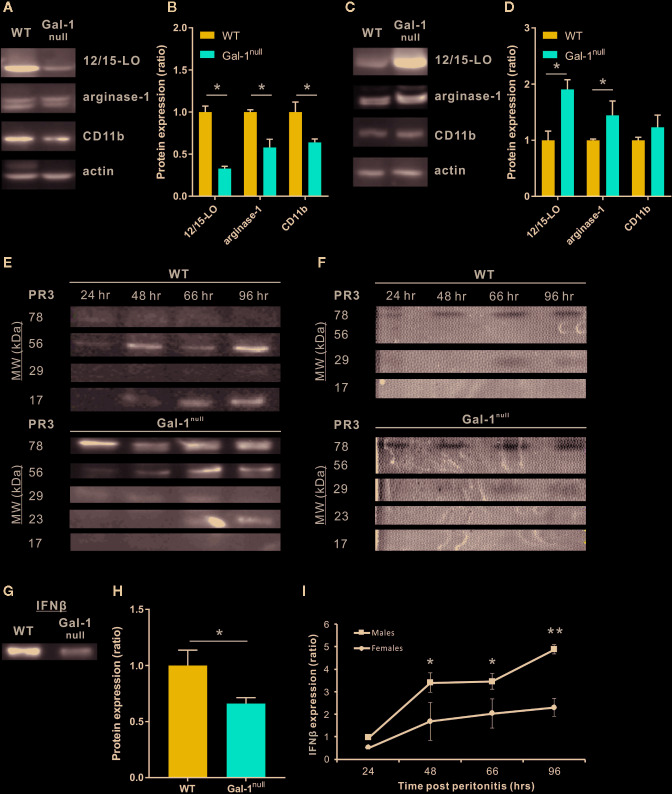
Gal-1null mice express diminished pro-resolving properties. (A, B) Peritoneal macrophages from WT and Gal-1null male mice were isolated at 48 h (A, B) and 66 h (C, D) PPI. The lysed macrophages were run by SDS-PAGE, followed by immunoblotting for 12/15-LO, arginase-1, CD11b, and actin as a loading control. (A, C) representative blot images. (B, D) graphs averaging protein expression after quantification by densitometry, normalizing to actin, and calculation of ratio to expression in WT macrophages. Full blot images are shown in
Figures S9
 and
10
. (E, F) Peritoneal exudates were collected at 24, 48, 66, and 96 h PPI. (E) Equal volumes of cell-free fluids were run by SDS-PAGE, followed by immunoblotting for PR3; representative blot images. (F) Proteolytic activity of PR3 in exudates was examined by casein zymography; representative gel images. Full blot and zymography images are shown in
Figure S11
. (G, H) Equal volumes of cell-free fluids recovered at 48 h PPI were run by SDS-PAGE, followed by immunoblotting for IFN-β; representative blots (G) and mean ± SEM (H) Full blot images are shown in
Figure S12
. (I) Peritoneal fluids were obtained from WT and Gal-1null male and female mice at 48 h PPI. IFN-β expression by Western blotting. Altogether, the data represent two to three independent experiments and are presented as mean ± SEM, n = 3–4. Statistical significance relative to WT mice (B, D, H) or between males and females (I) was analyzed by two-tailed Student's t-test; *p < 0.05, **p < 0.01.